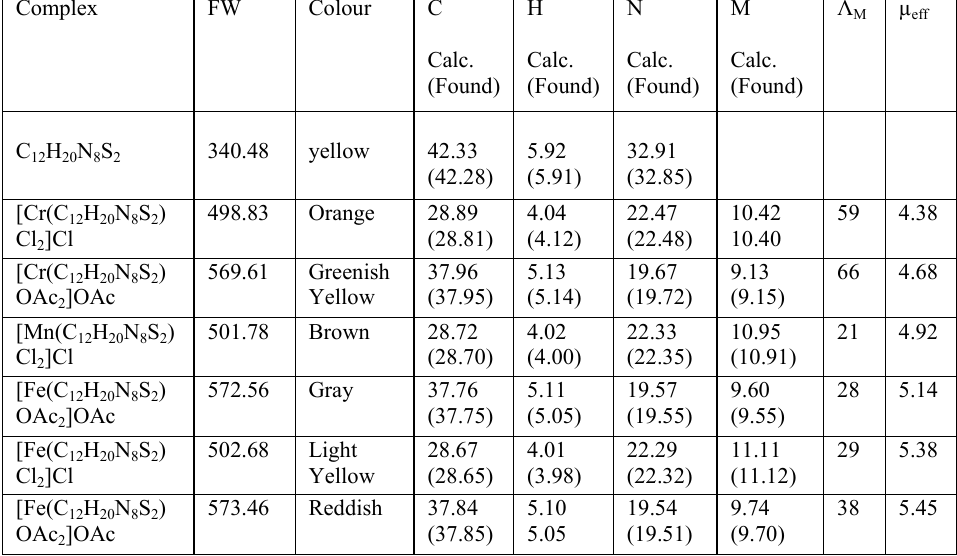
Table 1. Elemental analysis in % and molar conductance (Λ in DMSO) in Scm 2 mol -1 and M magnetic moment (µ ) in µ of the Schiff base ligand and its metal complexes. eff B Complex FW Colour C Calc.